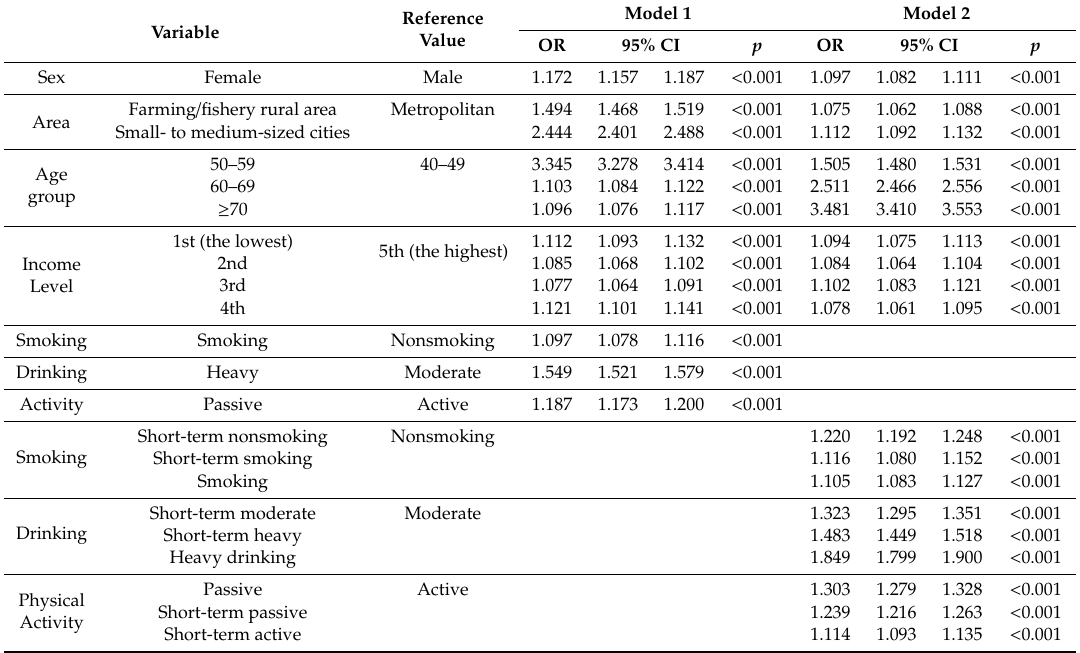
Table 5. Multiple logistic regression for metabolic syndrome